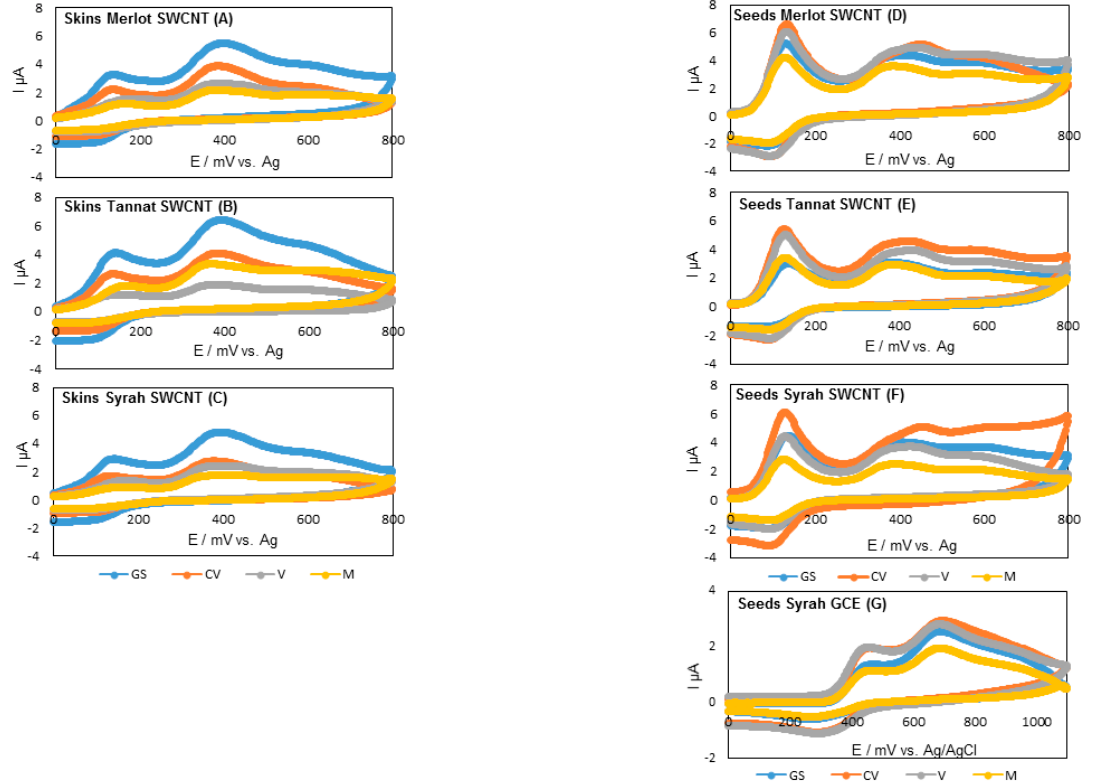
Figure 2. Cyclic voltammograms of skin ( A – C ) and seed grape extracts ( D – F ) with SWCNT and those of Syrah seed grape extract ( G ) with GCE at different stages of ripening (blank subtracted). GS: Green Stage; CV: Close to Veraison; V: Veraison; M: Maturity.